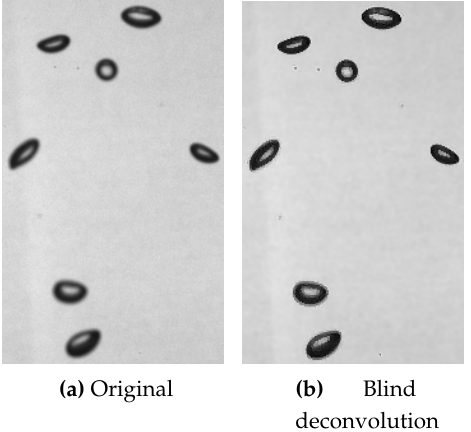
Figure 11. Experimental results of blind deconvolution on an input image with defocus: ( a ) shows the input image and ( b ) the result of gradient sparsity blind